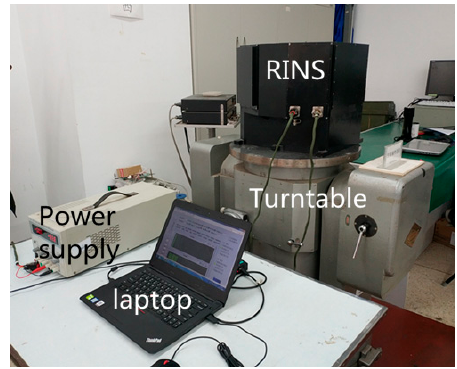
Figure 4. RINS and associated experimental equipment.